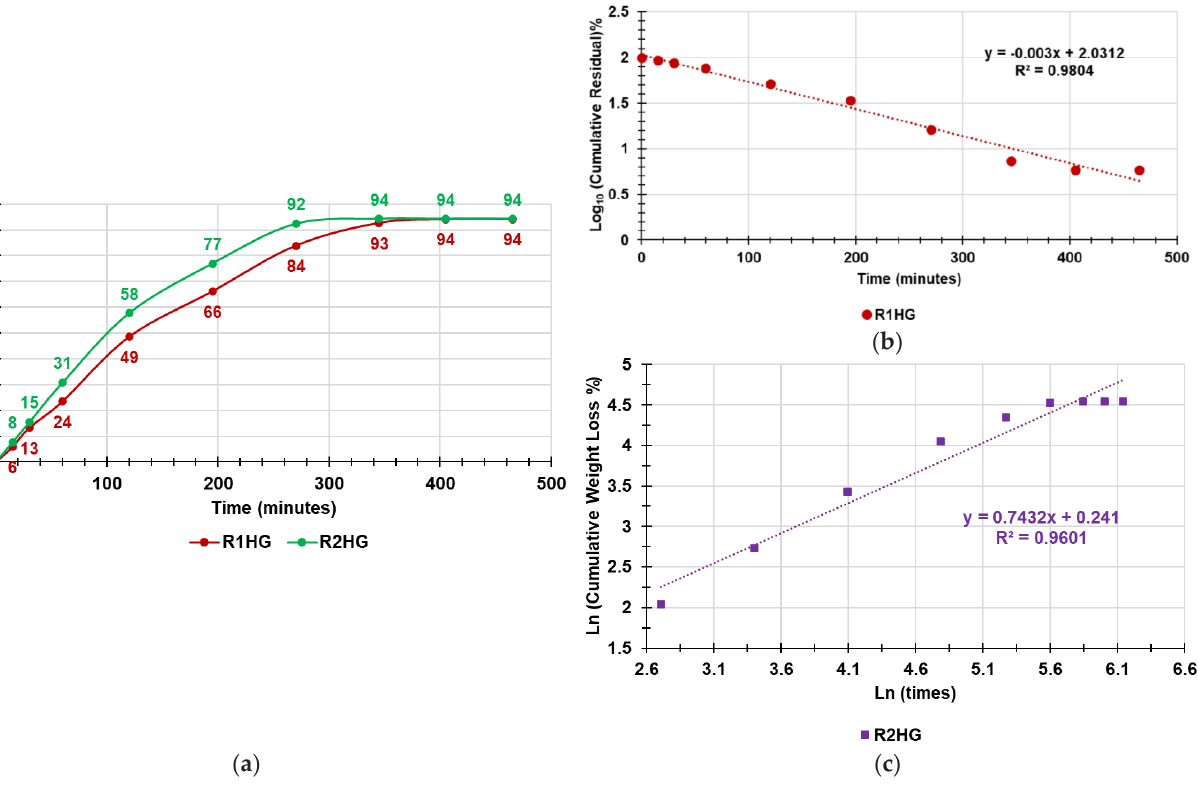
Figure 6. Cumulative weight loss percentage curves of R1HG (red line) and R2HG (green line) over time (465 min) and gentle heating (37 °C) ( a ); first order ( b ) and Korsmeyer-Peppas ( c ) kinetic models fitting data of cumulative weight loss curves of R1HG and R2HG, respectively.